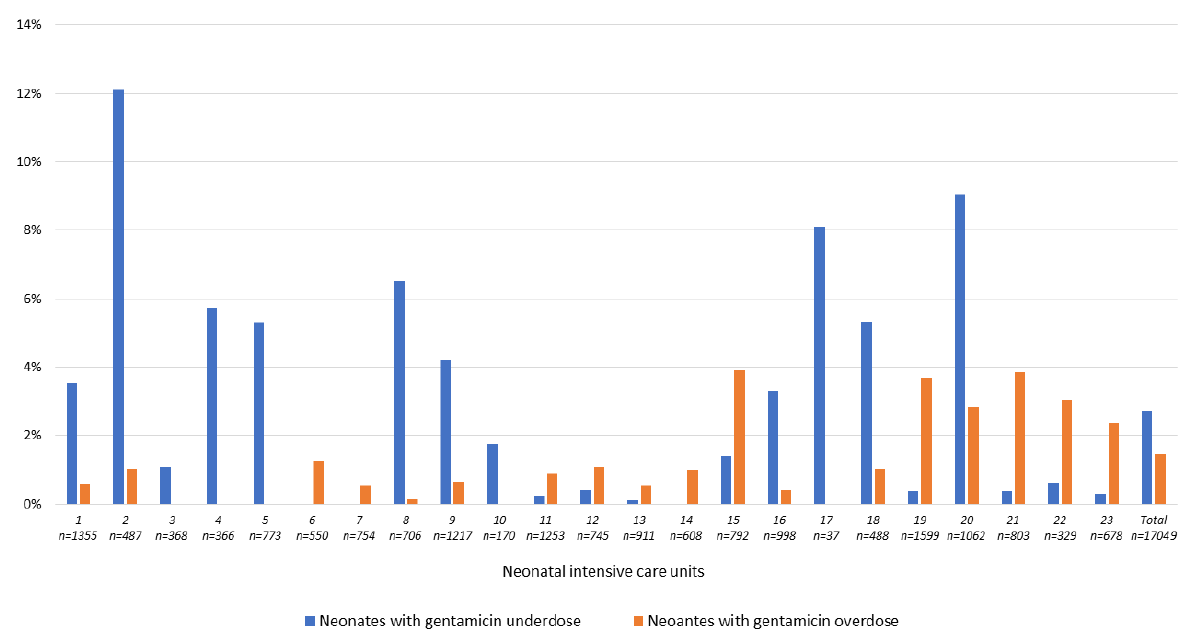
Figure 2. Proportions of neonates with at least one gentamicin over-or under-dosed prescription in 23 neonatal intensive care units.